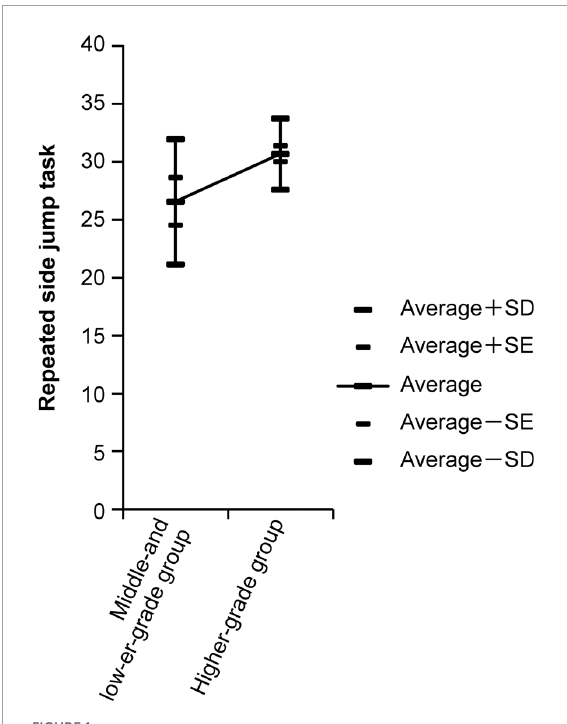
FIGURE1 The number of repeated side jumps in the second grade and the results of ANOVA for the higher-grade group and middle- and lower-grade groups in arts and crafts.